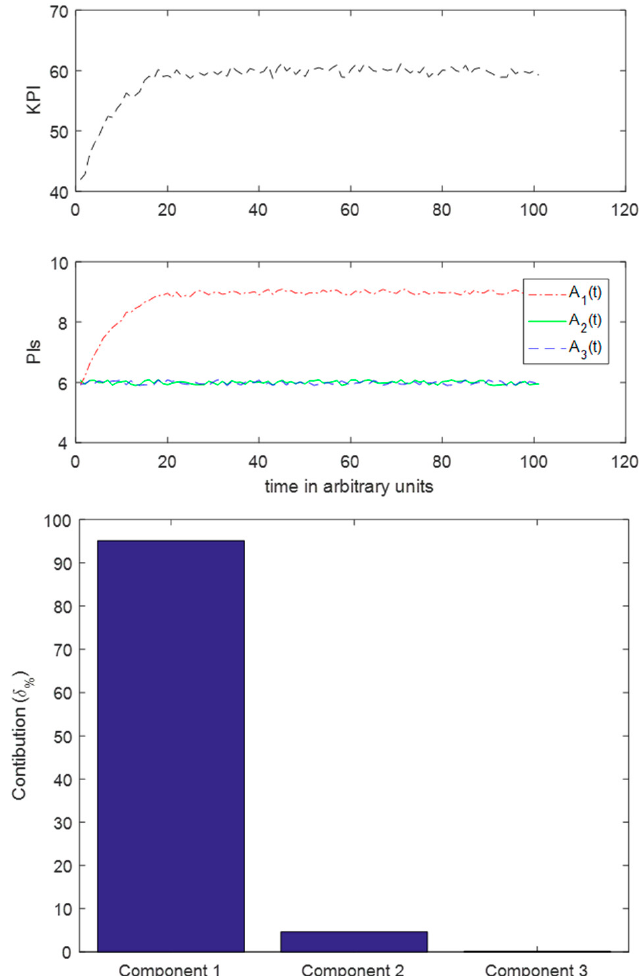
Figure 9. Case I. Top: Evolution of KPI, Middle: Evolution of PIs, Bottom, Contribution of each PI.